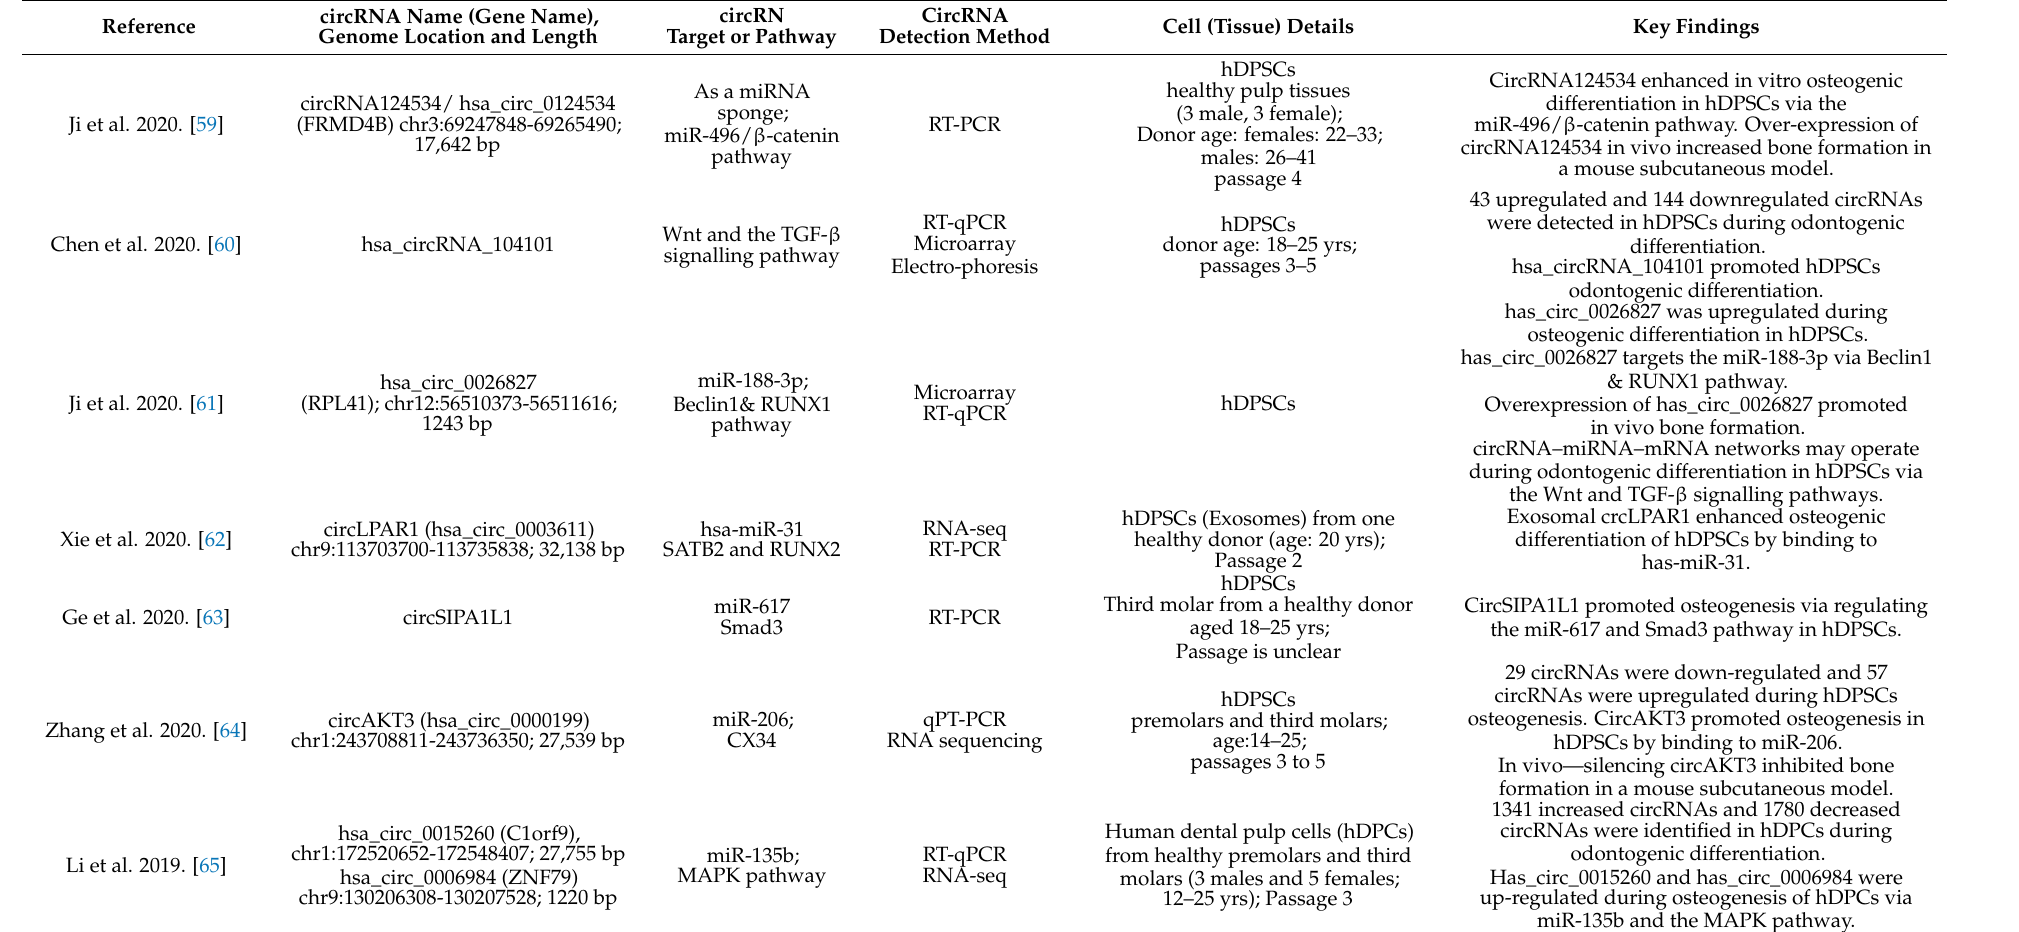
Table 3. Role of circRNAs expression in the differentiation of human dental pulp stem cells